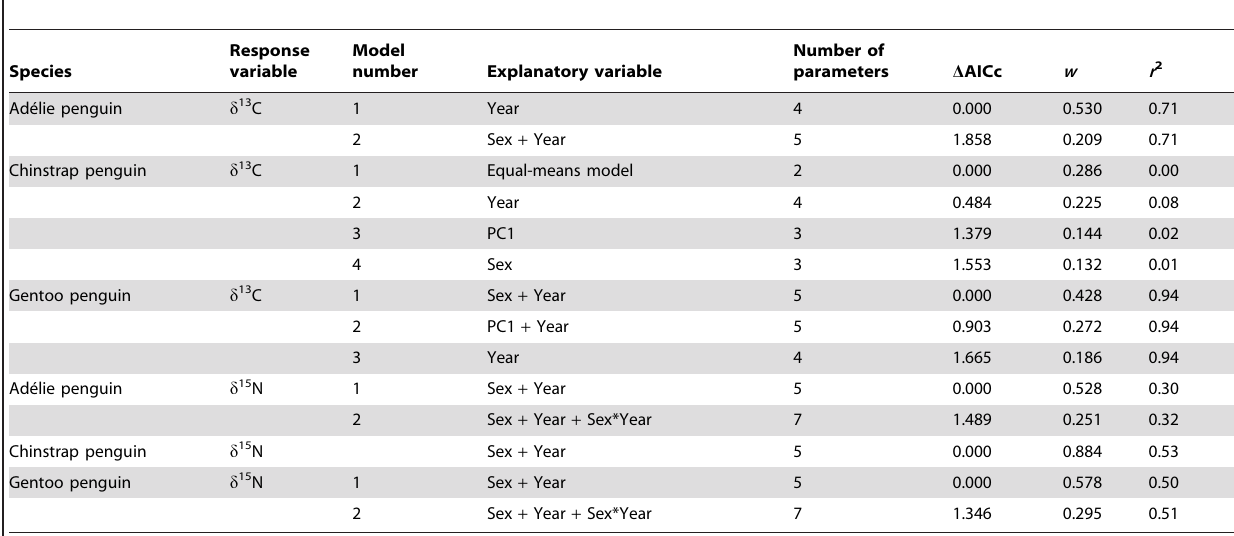
Table 3. Candidate models for describing variation in foraging niche of Pygoscelis penguins assessed by d 13 C and d 15 N stable isotope